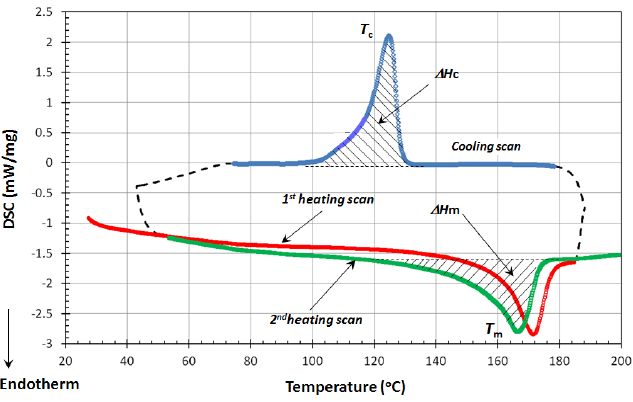
Fig. 5. Typical DSC thermograms of the